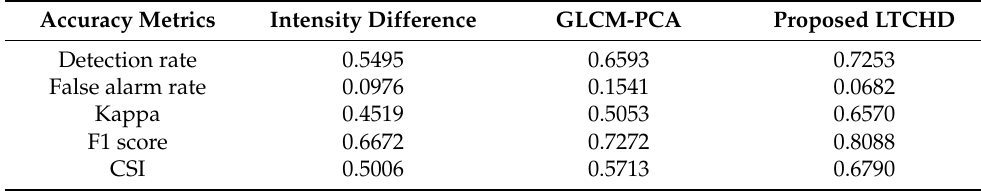
Table 2. Detection accuracies for the different methods.